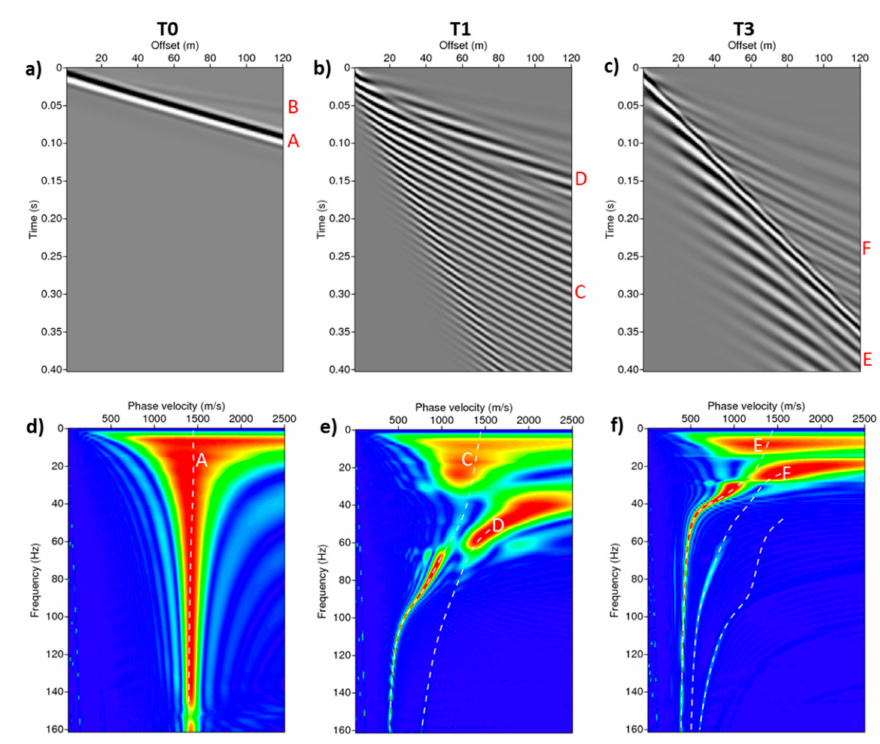
Figure 4. Top: synthetic seismic gathers for ( a ) model T0 (initial model, − 5 ◦ C through the column), ( b ) model T1 (top boundary temperature = + 1 ◦ C ), and ( c ) model T3 (top boundary temperature = + 10 ◦ C). Bottom: corresponding frequency-phase velocity spectra (FV-spectra) with theoretical modal curves computed from the input models overlaid for ( d ) model T0, ( e ) model T1, and ( f ) model T3. The traces are plotted with an Ormsby-filter (1–25–40–120 Hz) to enhance the low frequencies and reduce aliasing. The capital letters A–F indicate the various modes of surface waves: A, C, and E is the fundamental mode, and D and F is the first higher